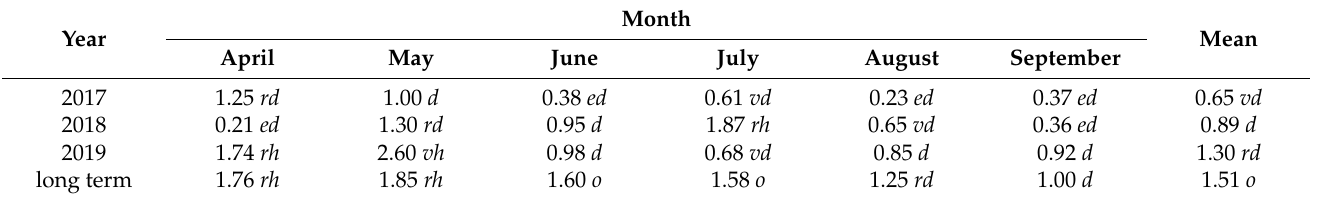
Table 2. Sielianinov’s hydrothermal index (k) in the growing